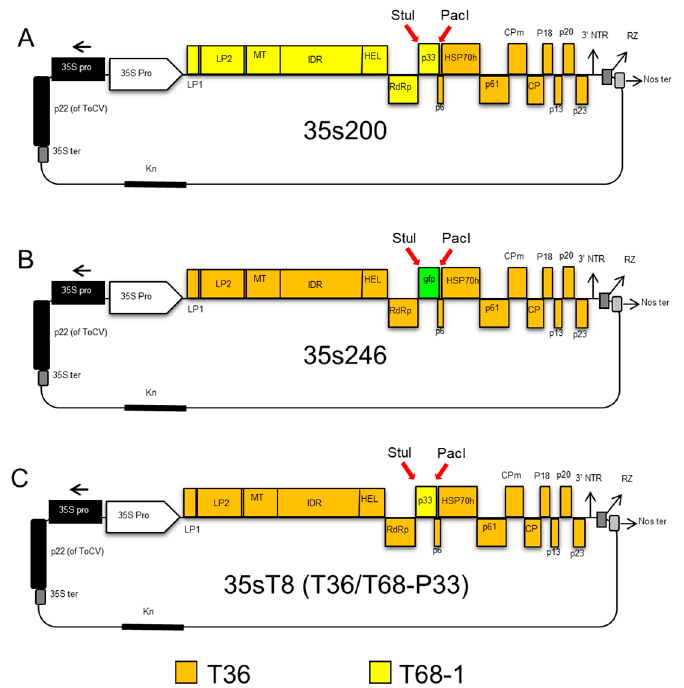
Figure 3. Schematic representation of cloning steps of the 35sT8 infectious hybrid created to isolate the p33 gene from the T68 strain. ( A ) The 35s200 hybrid used for amplification of the p33 gene of T68. ( B ) Hybrid 35s246 is an infectious cDNA clone of the T36 strain of CTV containing a gfp replacement of the p33 gene. ( C ) The 35s246 hybrid was digested with restriction enzymes StuI and PacI, and the gfp was replaced with the amplified p33 gene from 35s200 to produce the new infectious hybrid clone named 35sT8.